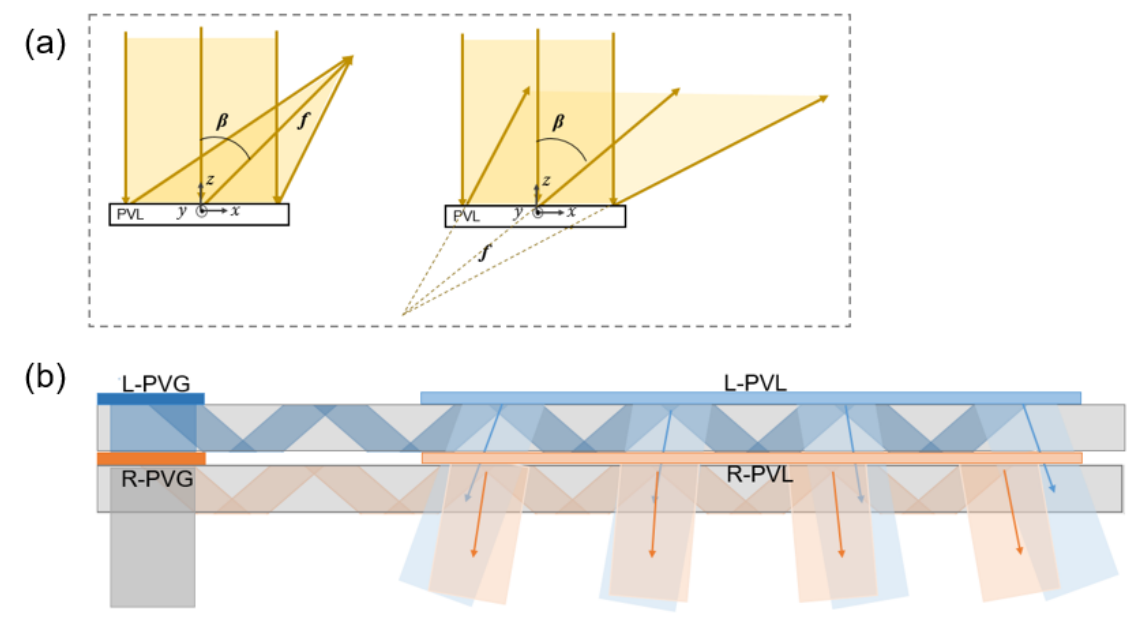
Figure 15. ( a ) Schematic diagram of PVL, ( b ) Schematic illustration of two-focal-plane waveguide-based AR system.